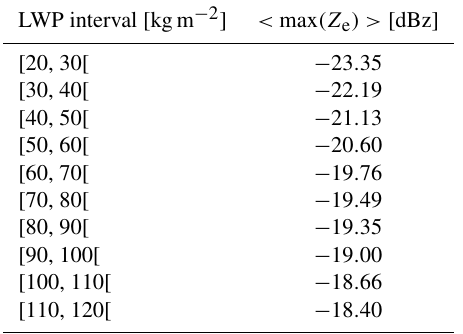
Table 4. Reference LWP–max (Z e ) relationship obtained at NSA using the mean of monthly LWP–max (Z e ) relationships weighted by the number of observations. Note that the mean O was likely around 1 ± 1dB for NSA, and the reported values in this table are corrected